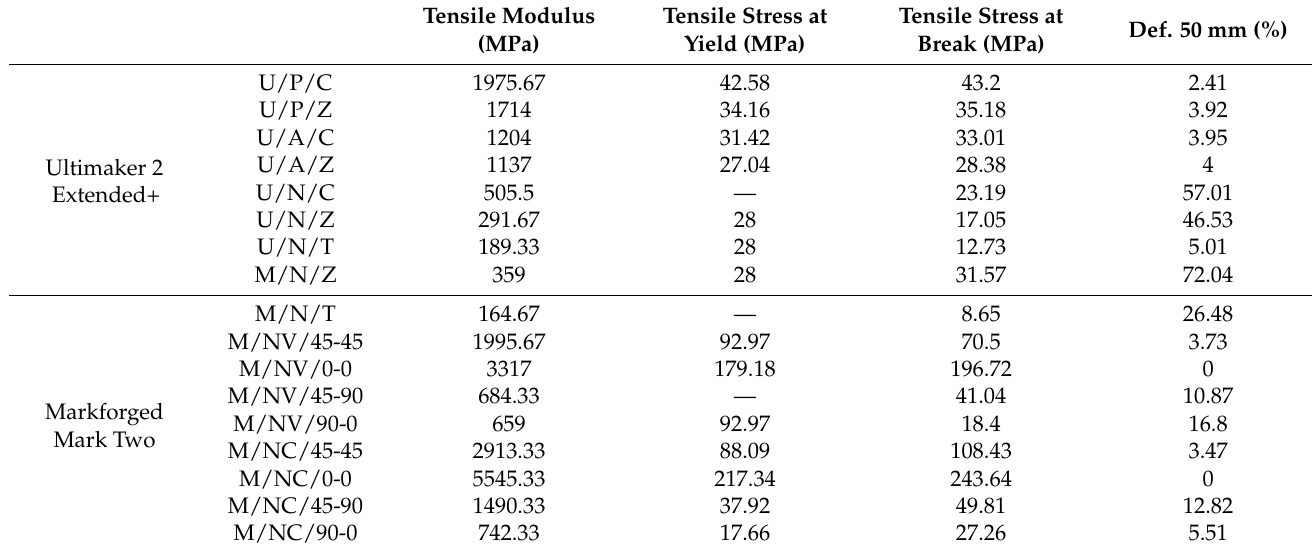
Table 5. Average values from tensile test